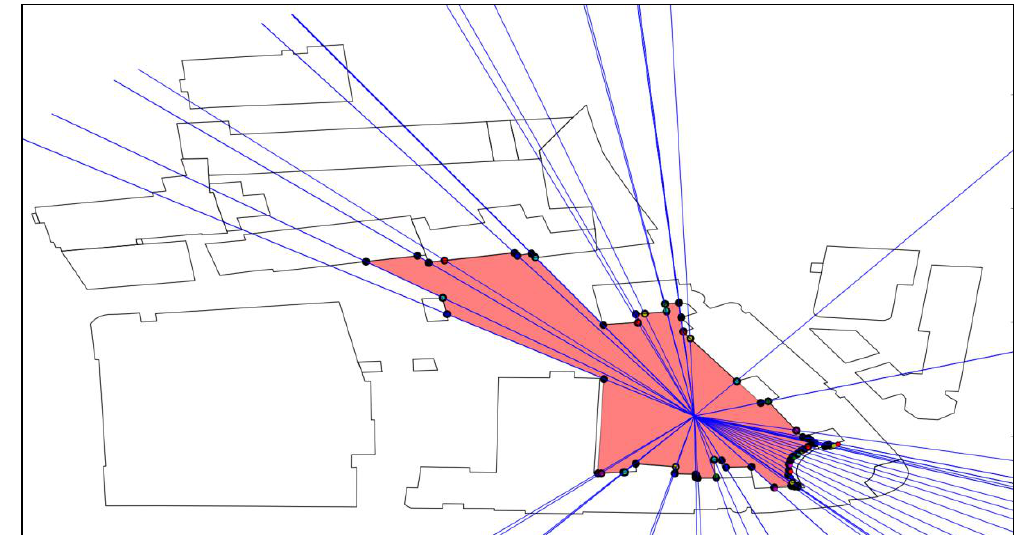
Figure 9. An example of generating horizontal rays out to the user specified radius and through the vertices of 2D Isovist/building footprint intersections.